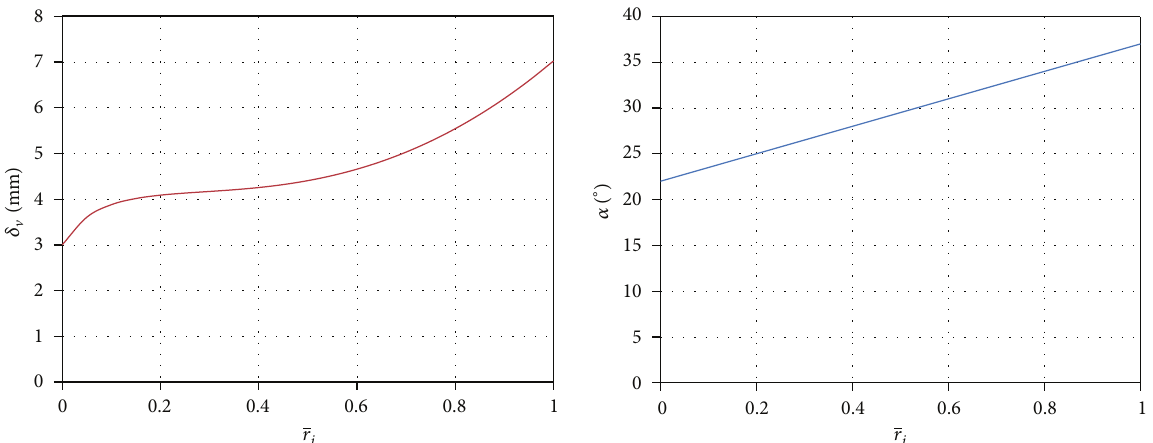
Figure 4: Vane thickness and angle distribution for the designed channel diffuser.